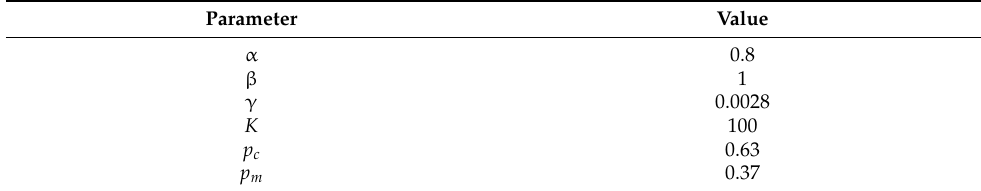
Table 2. The values of the genetic algorithm parameters used in the calculations.